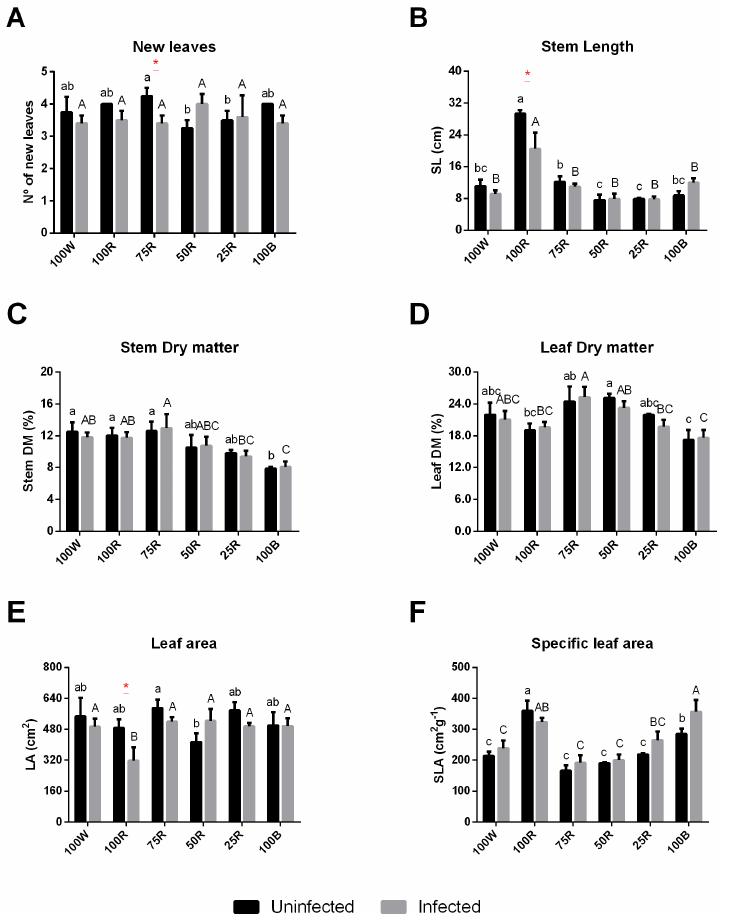
Figure 1. Effect of light quality on Actinidia chinensis var. deliciosa ‘Hayward’ biometric parameters and biomass. New leaves ( A ), Stem length (SL) ( B ), Stem dry matter (DM) ( C ), Leaf DM ( D ), Leaf area (LA) ( E ), Specific leaf area (SLA) ( F ). The values are presented as the mean of at least 3 biological replicates ± SE. Lowercase letters represent multiple comparisons of uninfected groups, capital let- ters are multiple comparisons of infected groups and asterisks are comparisons of uninfected and infected groups in the same light treatment. Mean values with the same letter or without asterisk are not significantly different (Fisher LSD, p < 0.05).